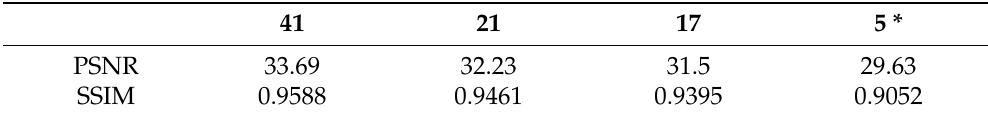
Table 1. Average PSNR and SSIM for all images in the dataset using focal stacks of varying sizes. For focal stacks with five images, the focal stack images used are captured between the maximum and minimum depth value for the depth range of each